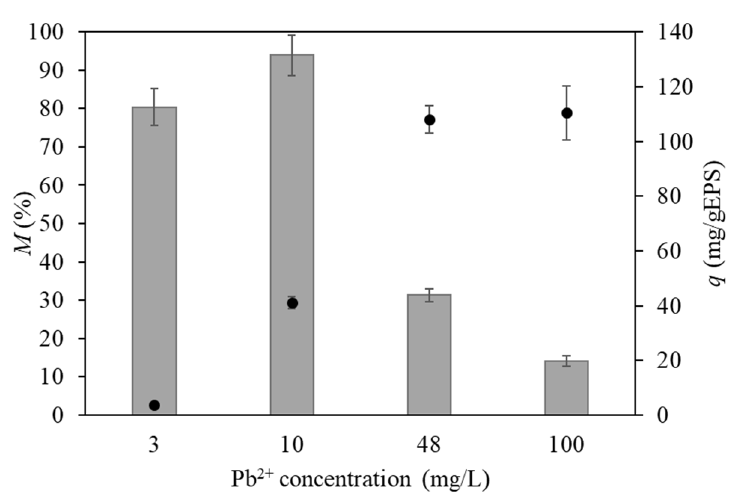
Figure 1. Biosorption of Pb 2+ , Cu 2+ , Zn 2+ and Co 2+ ( Ci 10 mg/L) by FucoPol (5 g/L) in terms of metal Figure 2. Specific metal uptake ( q , ● ) and removal efficiency ( M , ) by FucoPol (5 g/L) using different removal efficiency ( M , ) and specific metal uptake ( q , ● ) (temperature 21 °C, incubation time Figure 2. Specific metal uptake ( q , • ) and removal e ffi ciency ( M , ) by FucoPol (5 g / L) using di ff erent initial Pb 2+ concentrations (temperature 21 °C, incubation time 24 h). 24 h). initial Pb 2 + concentrations (temperature 21 ◦ C, incubation time 24